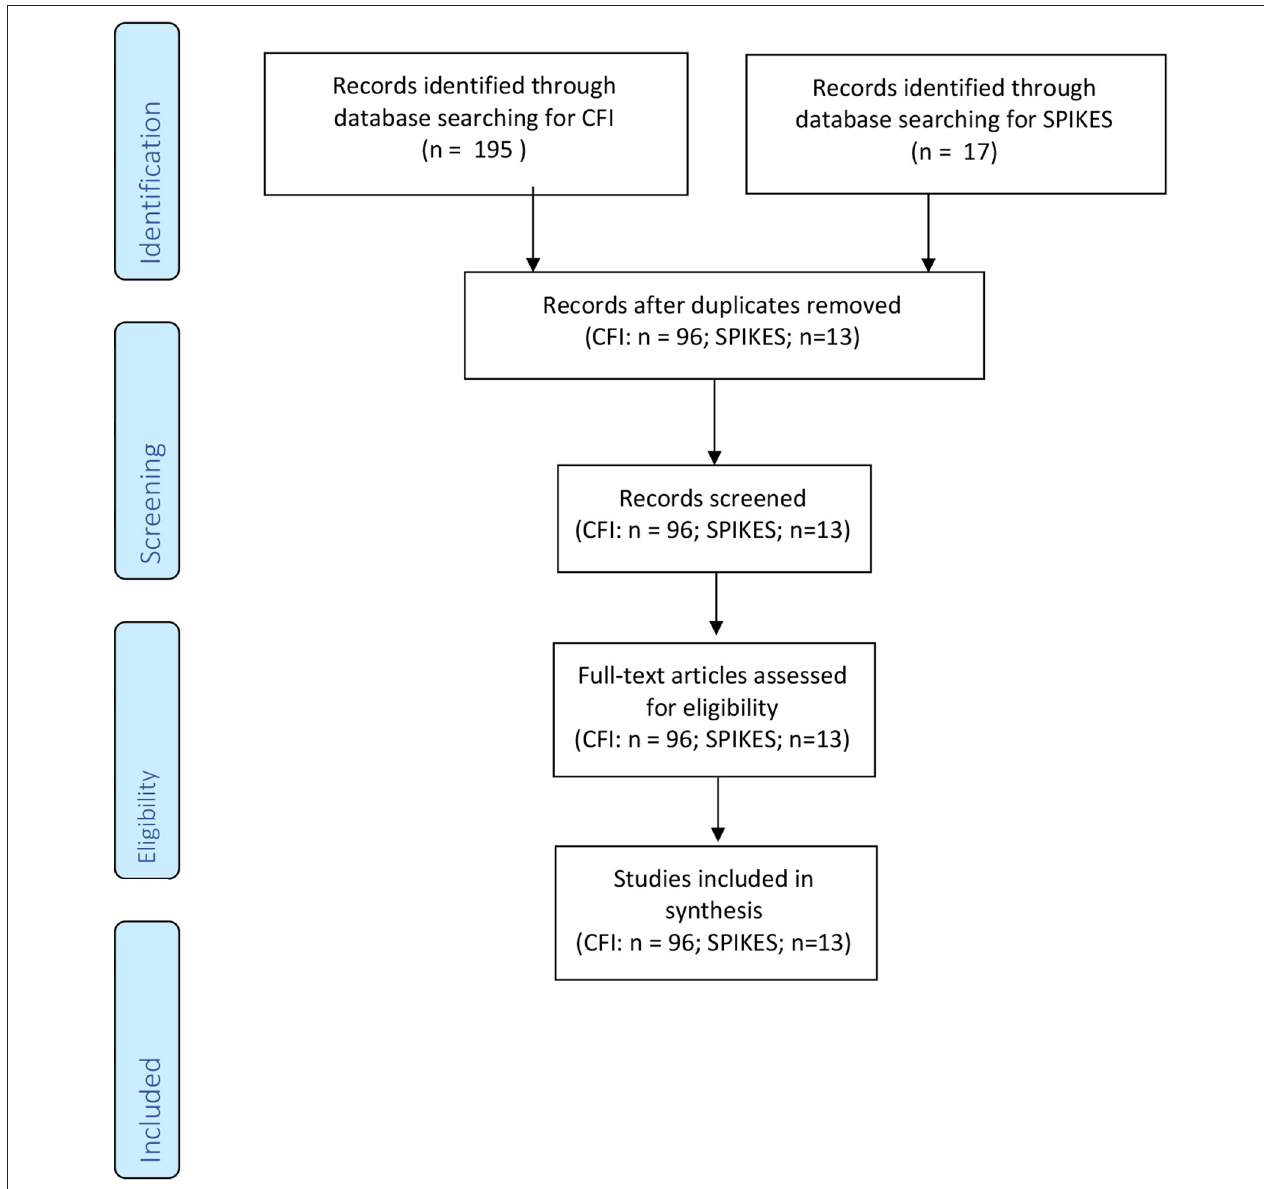
FIGURE 1 | Review of the feasibility of the SPIKES and CFI